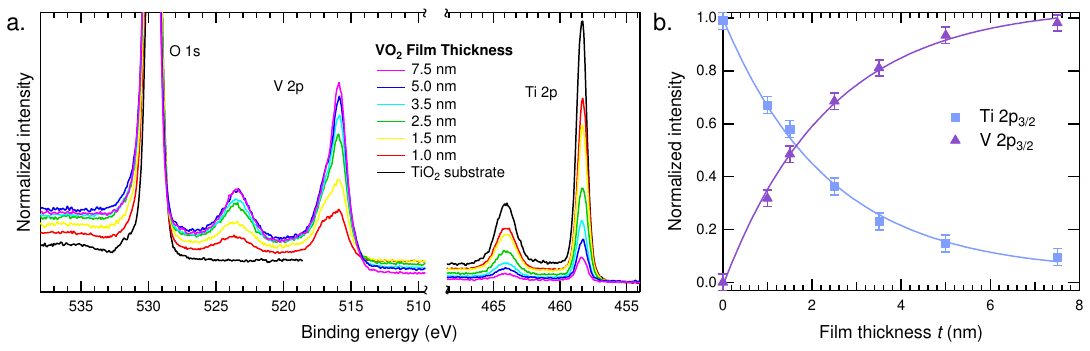
Figure 2. ( a ) X-ray photoelectron spectroscopy (HAXPES) spectra collected from six VO (100) thin films with thicknesses varying from 7.5 to 1 nm; ( b ) normalized HAXPES signal intensity of the V 2p and Ti 2p versus film 3 / 2 3 / 2